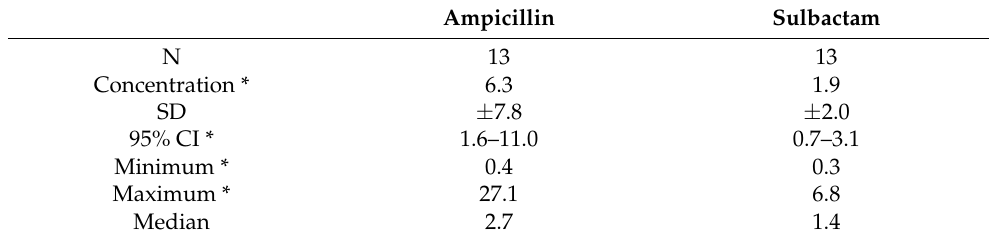
Table 3. Concentrations of ampicillin and sulbactam in vital bone samples.